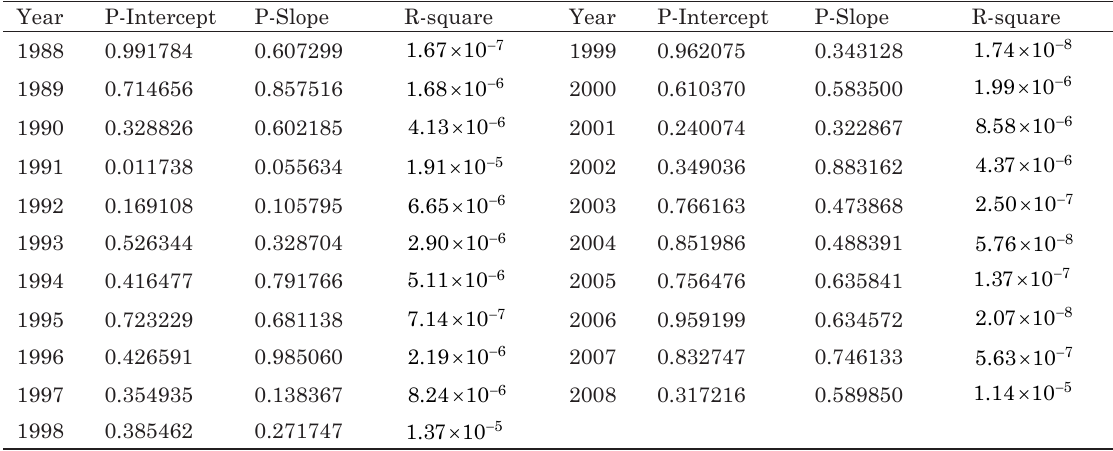
table 4. P-values of intercept and slope;